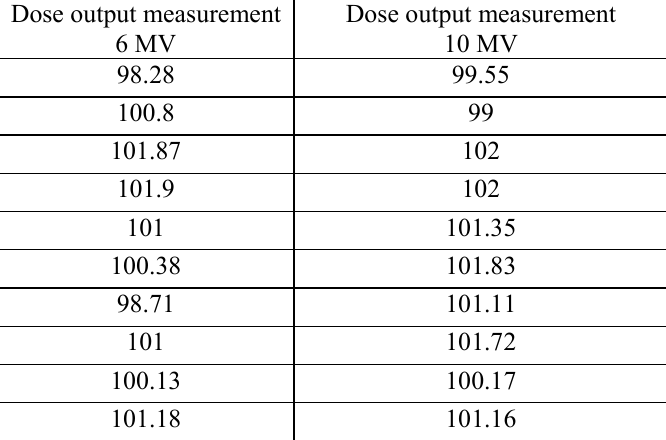
Table 1: Dose output measurements by star track